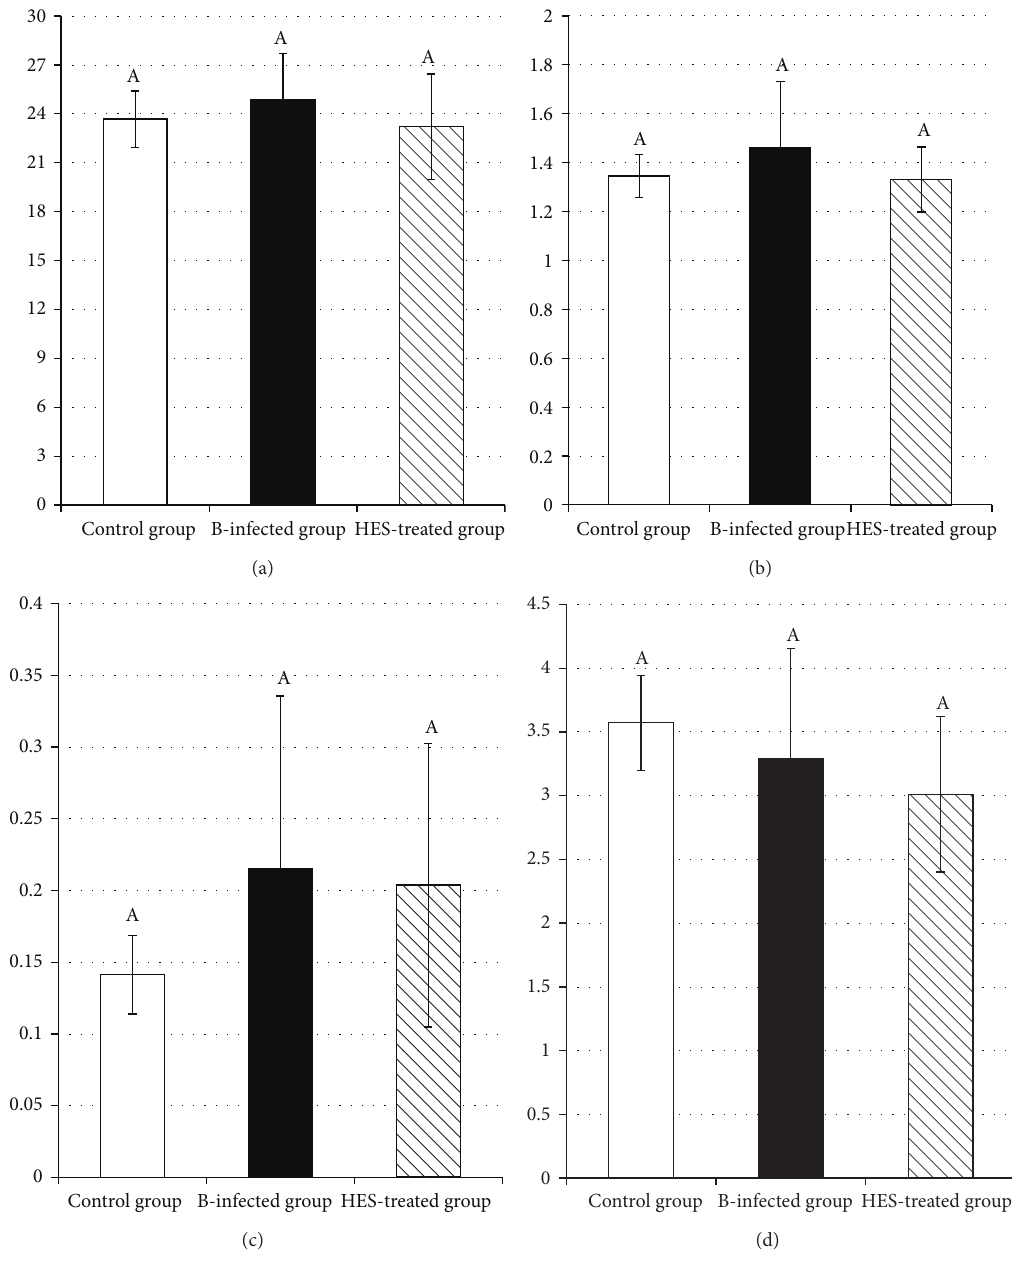
Figure 1: In vivo effect of hesperidin inoculation on body weight (a), liver weight/g (b), spleen weight/g (c), and intestine weight/g (d). Mice were infected, each with 2 × 10 8 CFU of Aeromonas hydrophila per week for four consecutive weeks (B-infected group), and treated simultaneously with hesperidin at a dose of 250 mg/kg/week for four consecutive weeks (HES-treated group). At the end of week 4 following exposure and treatment, mice were sacrificed and weighted, the liver, spleen, and intestine were weighted, phagocytic activity was estimated in fresh blood, and intestinal ROS production was evaluated in intestinal homogenate. Values not sharing common superscripts denote significant